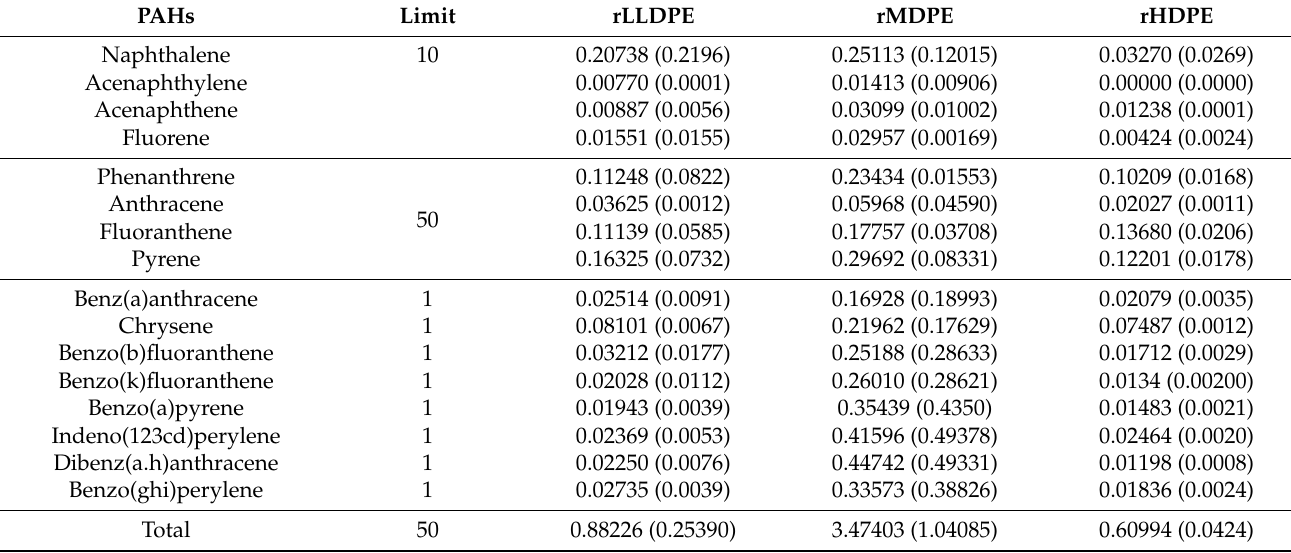
Table 6. PAHs in recycled LLD PE, MDPE, and HDPE.